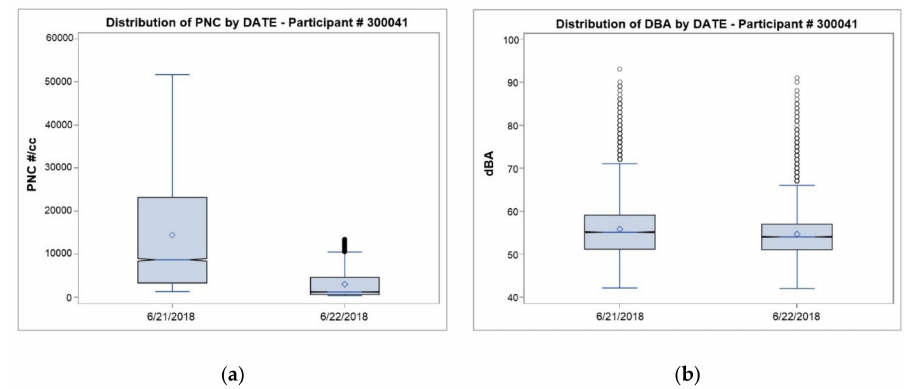
Figure 9. Boxplots of UFP (# particles/cc) and Noise (dBA), participant #300041 (21–22 June 2018).